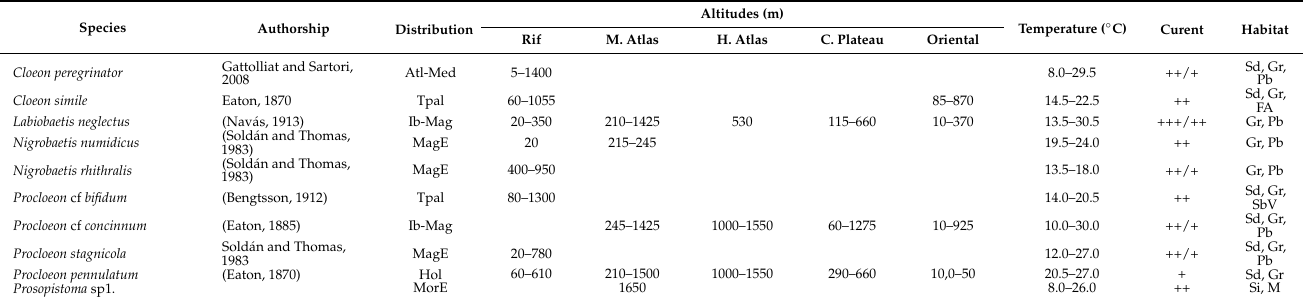
Table legend: Distribution patterns: Hol: Holarctic. Tpal: Transpalearctic. Wpal: Western Palearctic. Atl-Med: Atlanto-Mediterranean. Ib-Mag: Ibero-Maghrebian. MagE: Maghrebian endemic. MorE: